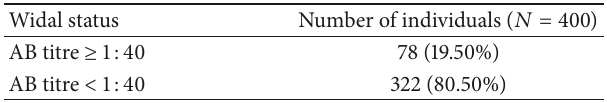
Table 1: Widal test results.